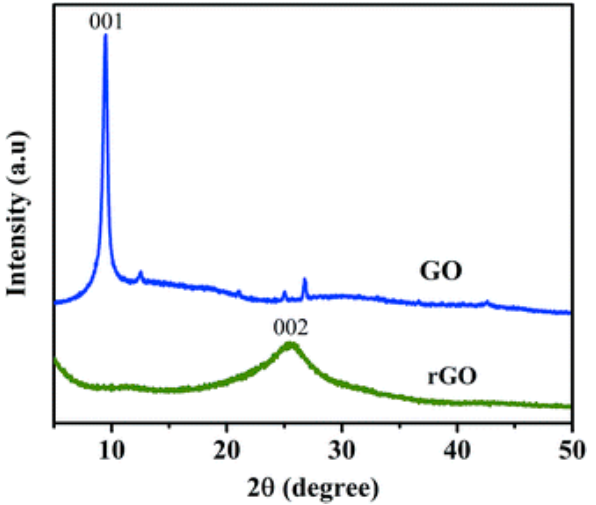
Figure 21. XRD pattern of as-synthesized graphene oxide and reduced graphene. Reproduced from [121] with permission from The Royal Society of Chemistry.